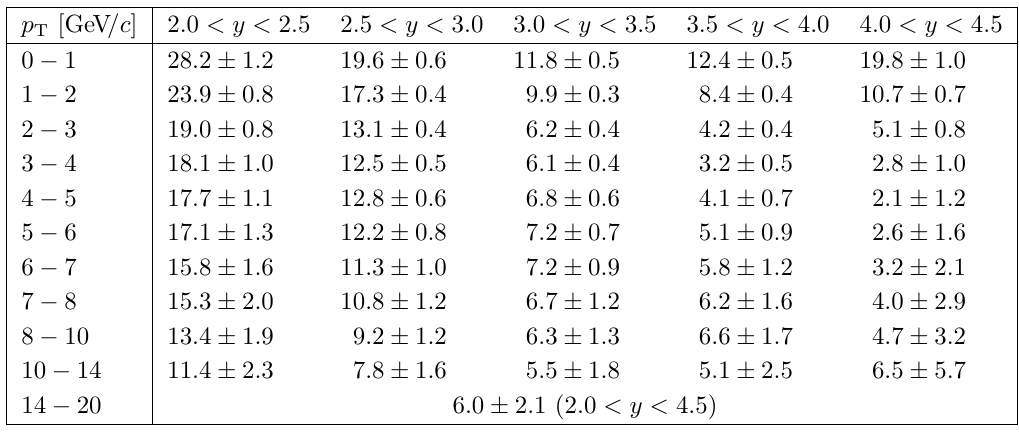
Table 20 . Relative changes of cross-sections (in %), for a polarisation of λ θ = +1 rather than zero, in ( p T , y )